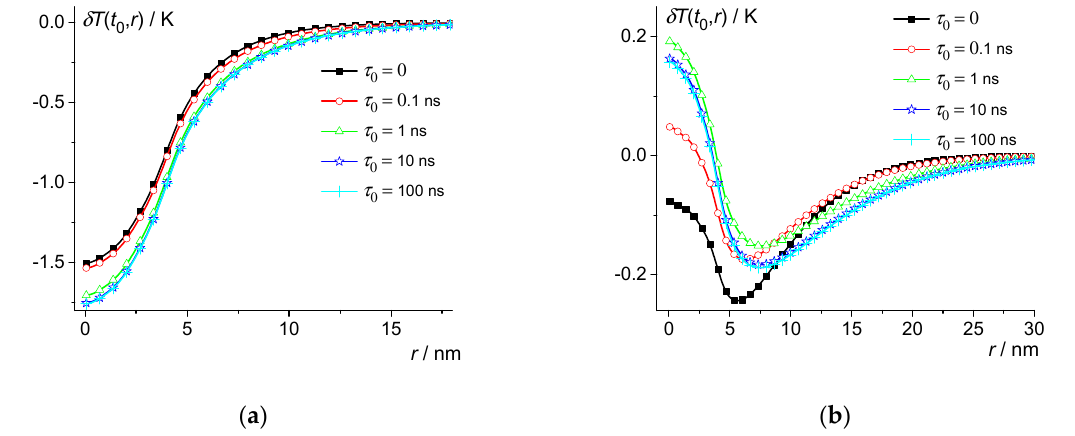
Figure 2. Dependence of the temperature change δ T ( t 0 , r ) on distance r at t 0 = 0.25 ns ( a ) and t 0 = 0.57 ns ( b ) for the silicate glass Na 2 O · 2CaO · 3SiO 2 at ∆ T = 200 K; τ 0 = 0, 0.1 ns, 1 ns, 10 ns, and 100 ns—squares, circles, triangles, stars, and crosses.